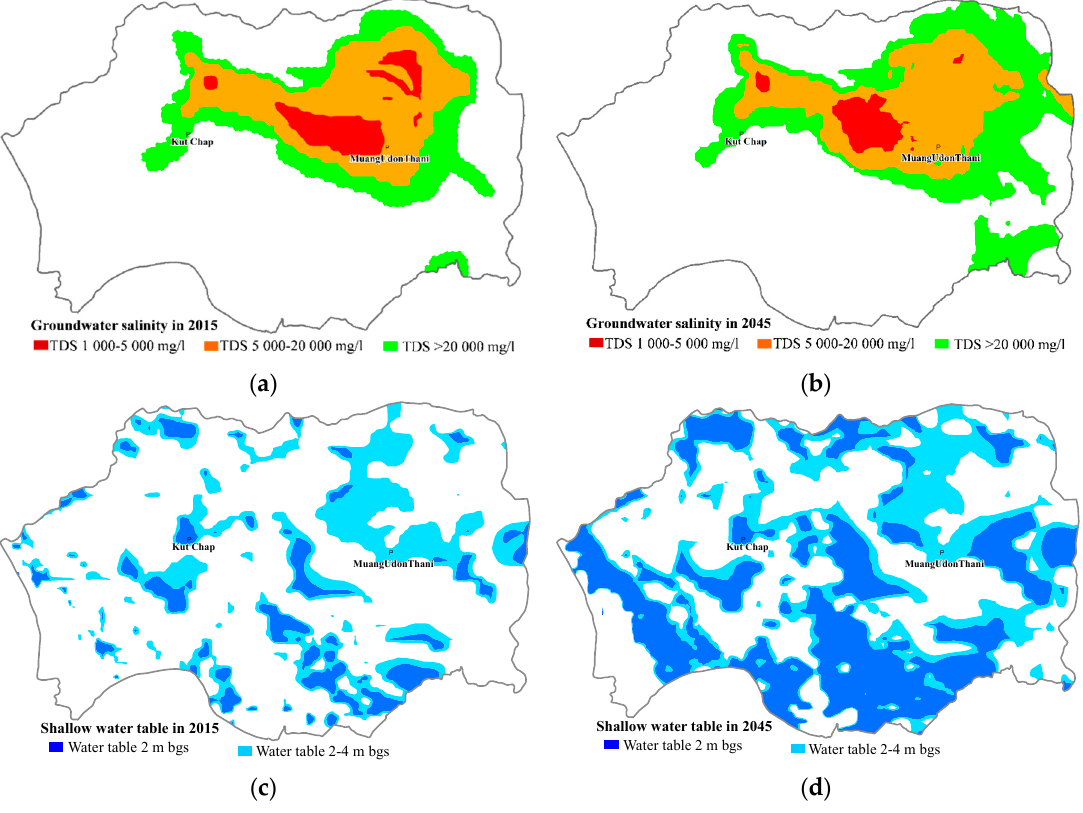
Figure 18. Groundwater salinity distribution of shallow water table. ( a ) Groundwater salinity distribution in 2015; ( b ) Groundwater salinity distribution in 2045 of model B (RCP8.6); ( c ) Shallow water table distribution in 2015; ( d ) Shallow water table distribution in 2045 of model A (RCP8.6).